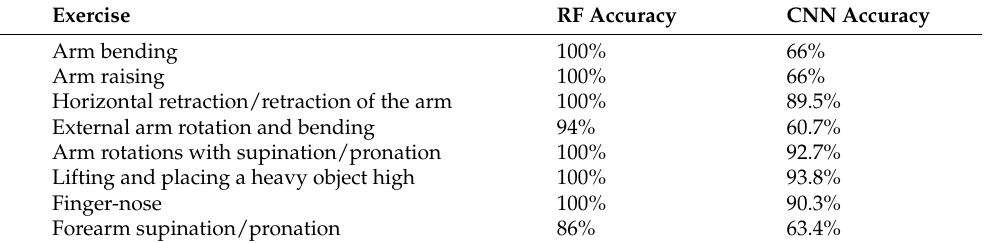
Table 6. Classification results of data (angles) recorded during motion using RF and CNN methods.